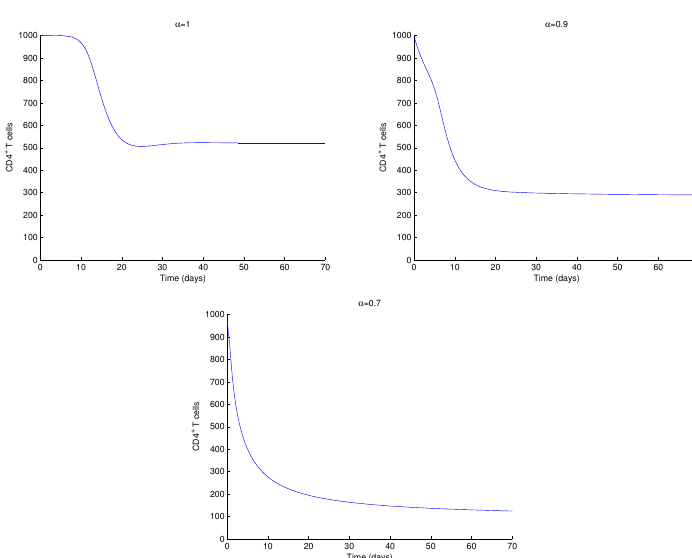
Figure 1. Dynamics of the CD4 + T cells, T , of system (1) without PEP for α = 1 ( top left ), α = 0.9 ( top right ) and α = 0.7 ( bottom ). Parameter values and initial conditions in the text.